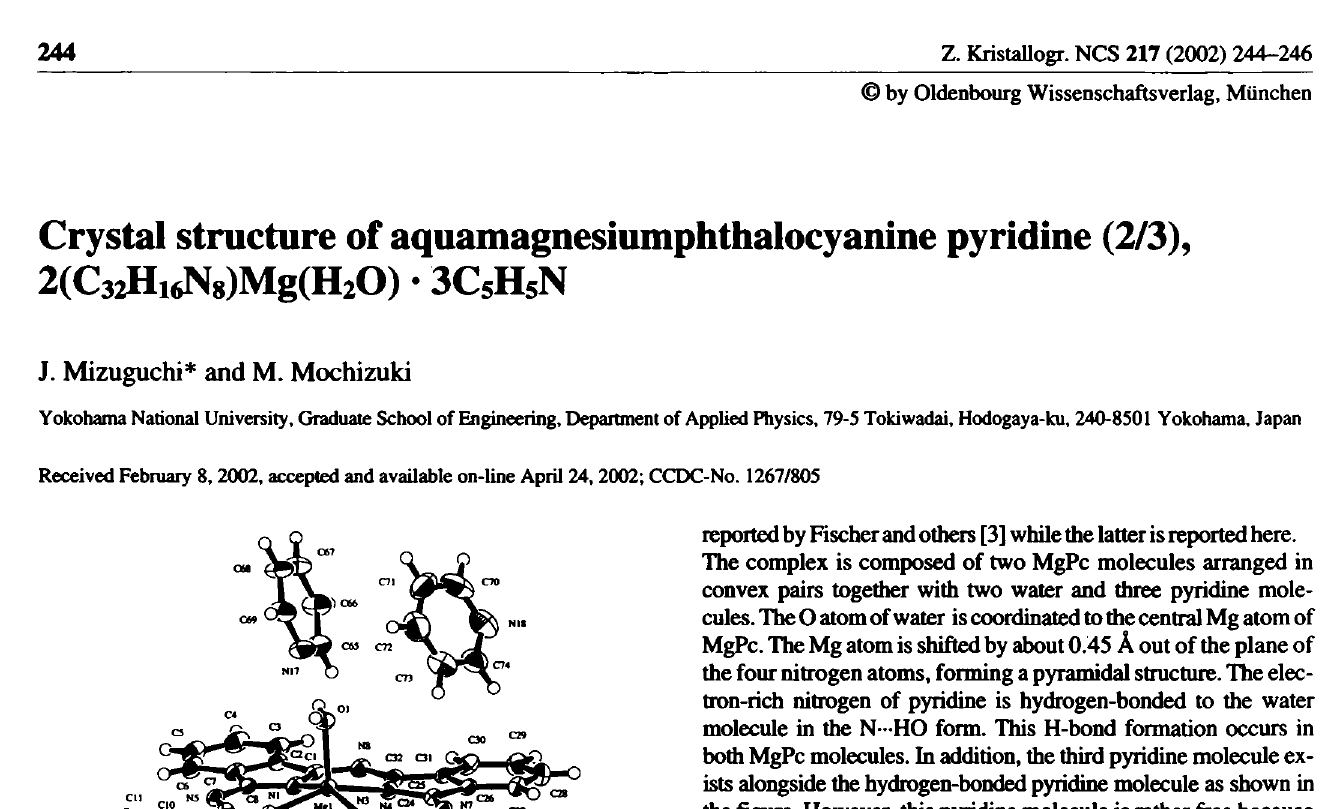
Table 1. Data collection and handling.